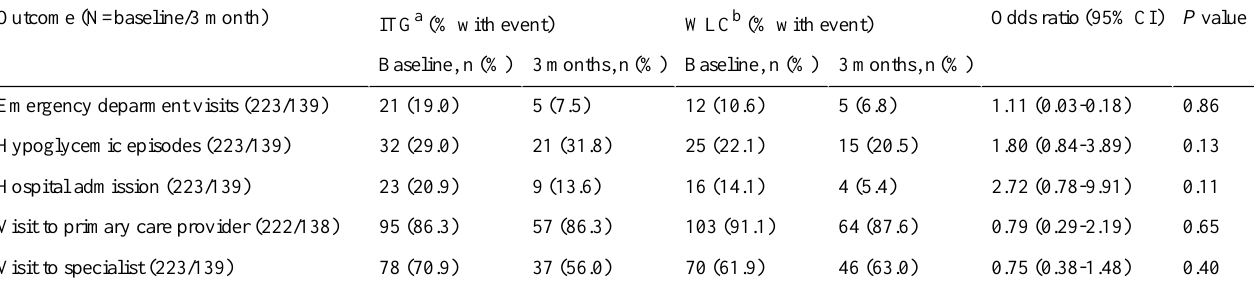
Table 2. Health service